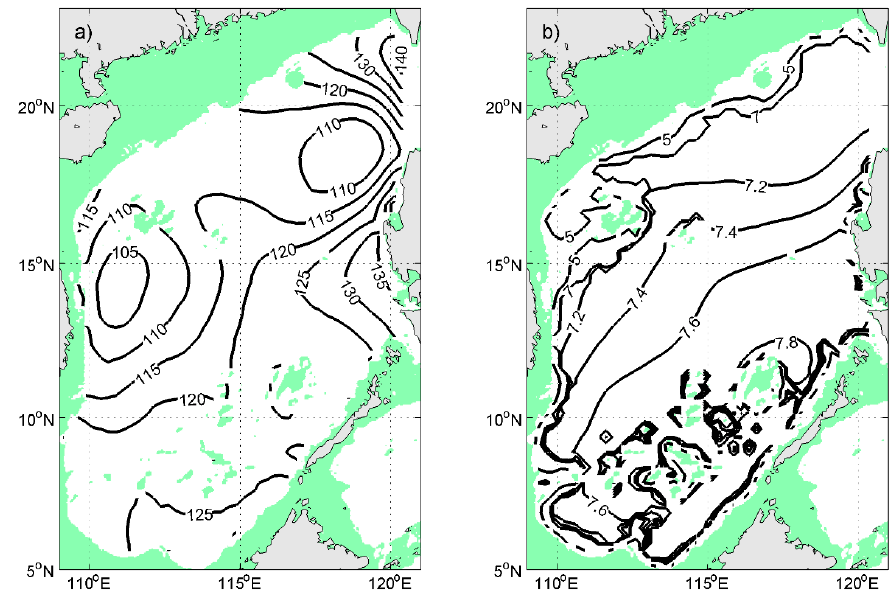
Figure 5. Climatological mean ( a ) ULT (CI: 5 m) and ( b ) ε ( × 10 − 3 ) in the South China Sea derived from the World Ocean Atlas 2013.